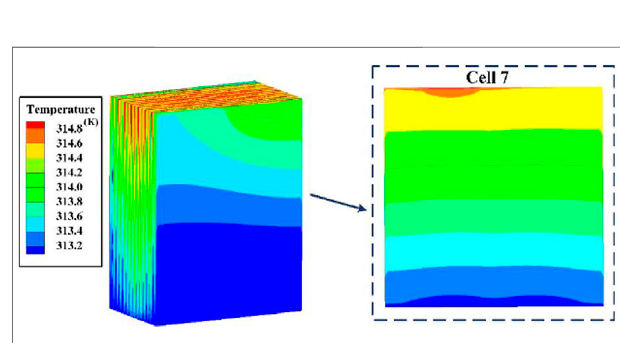
FIGURE 9 | Temperature cloud map.